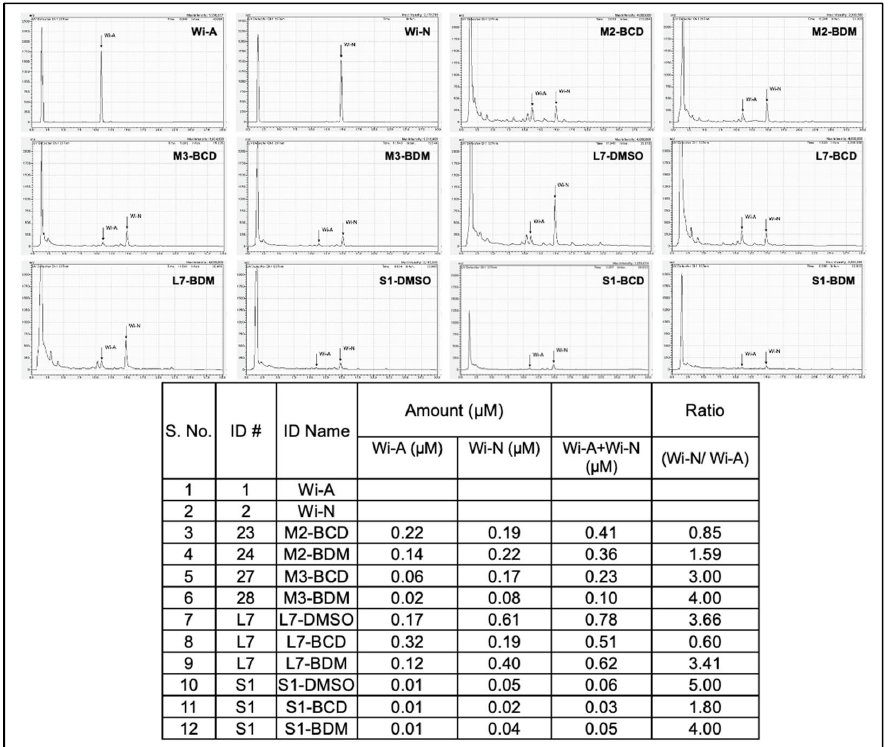
Figure 3. HPLC analyses for the contents of Wi-A and Wi-N in Ashwagandha leaf and stem extracts.